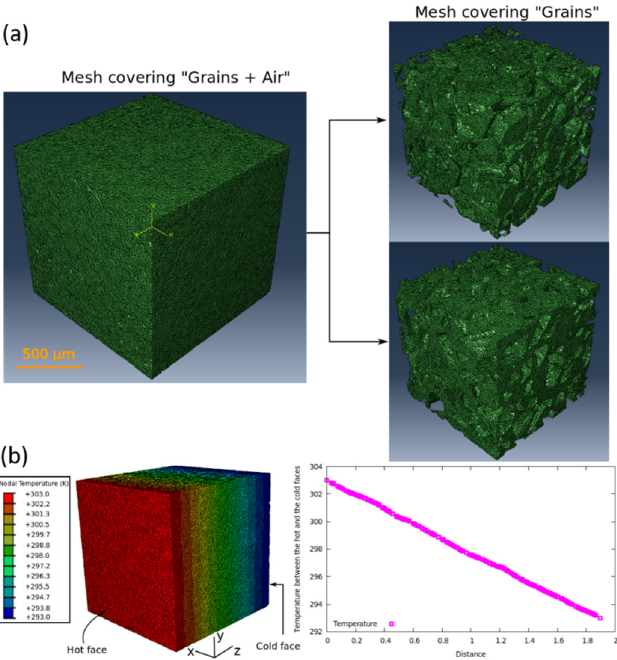
Figure A3. Meshed volumes based on 3D-reconstructed X-ray tomogram: ( a ) monomodal SAP composite recombined or not; ( b ) nodal temperature view within a bound bimodal composite.